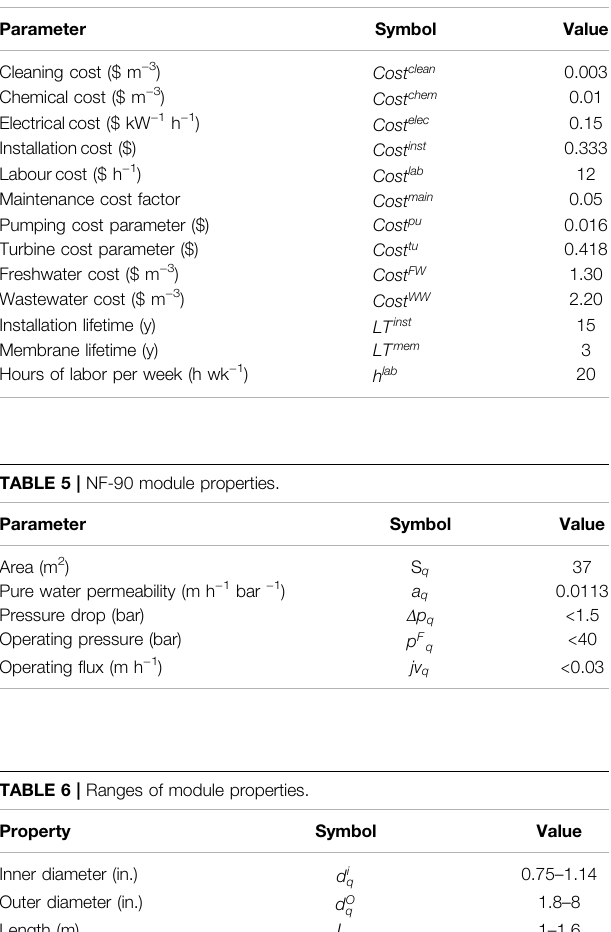
TABLE 4 | Costing parameters.